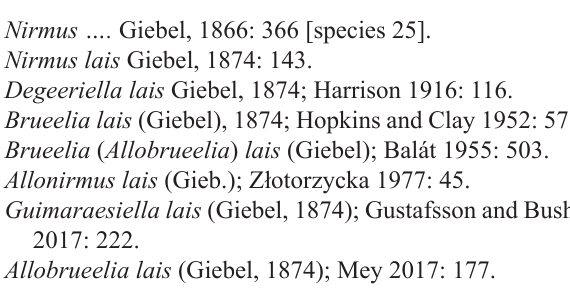
thorn-like vss on each side; 3 or 4 short, slender vos